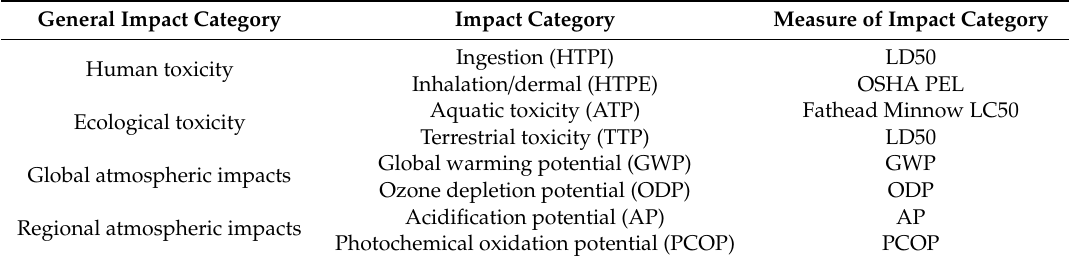
Table 2. Impact categories in the waste reduction (WAR) algorithm